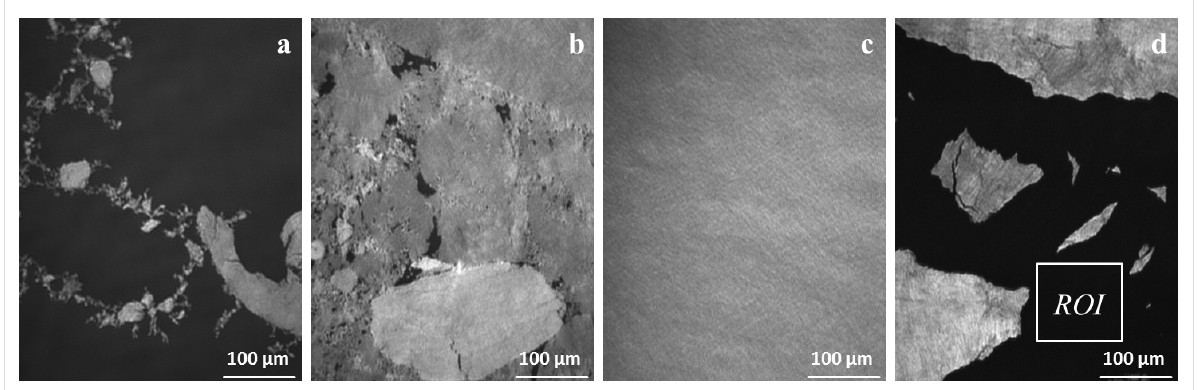
Figure 2: Brewster angle microscopy images of star-shaped PPDL-D4 at different compression states recorded on water at 22 °C. (a) 0.0 mN·m − 1 ; (b) 0.8 mN·m − 1 ; (c) 10 mN·m − 1 ; (d) film rupture after stress release (imaging ellipsometry).